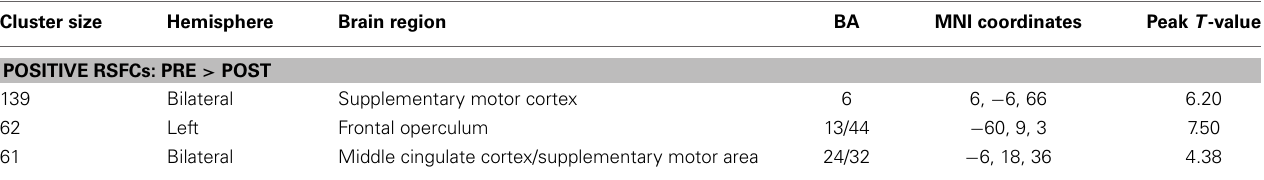
Table 2 | Significant changes in functional connectivities before and after HDT bed rest using the left aINS as the seed region. Cluster size Hemisphere Brain region BA MNI coordinates Peak T -value